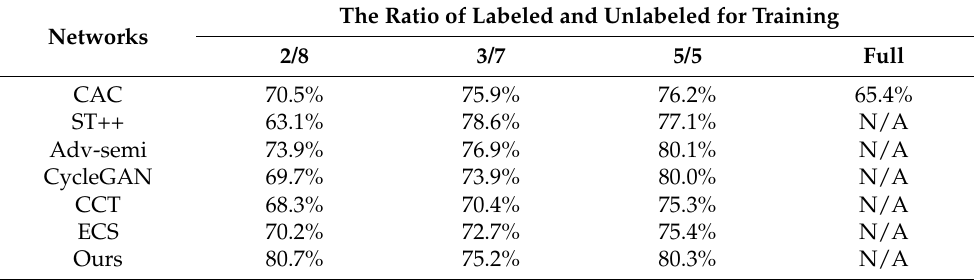
Figure 10. Enlarged visualization of segmentation results using the proposed method and state-of-art methods on the Flame dataset. Table 2. Comparison with the baseline and other state-of-the-art methods on Corsican dataset with 2/8, 3/7, 5/5 and full labeled